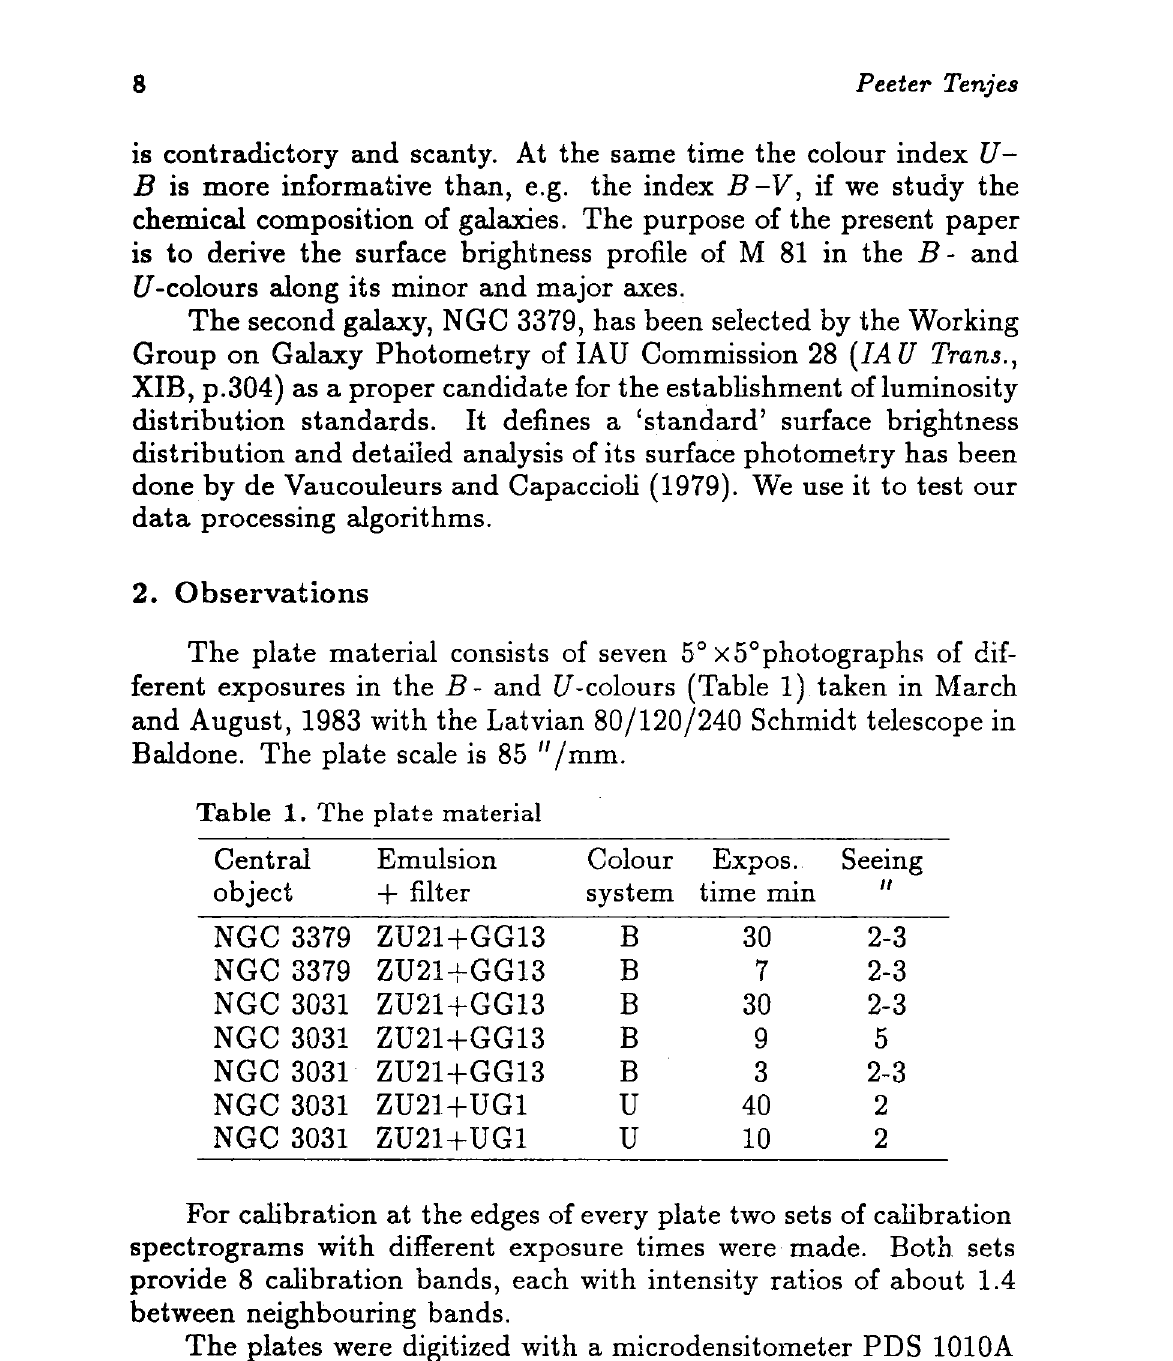
Central Emulsion Colour Expos. Seeing